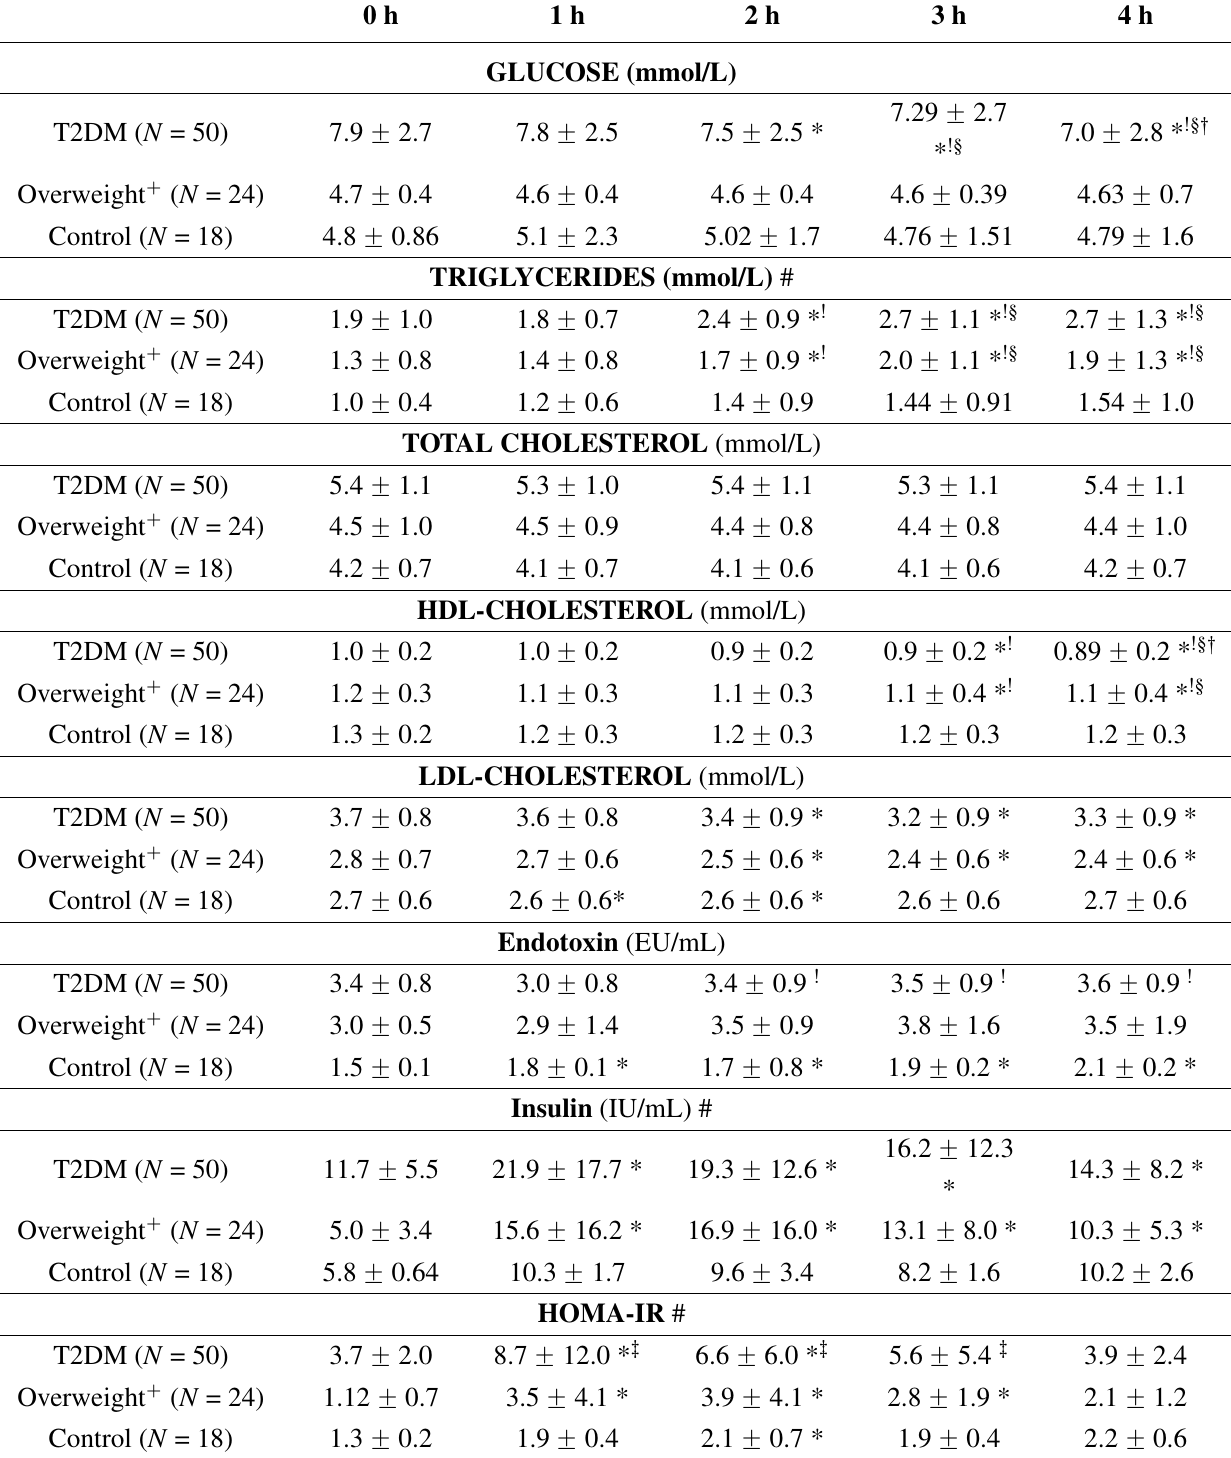
Table 2. Metabolic changes pre- and post-high-fat